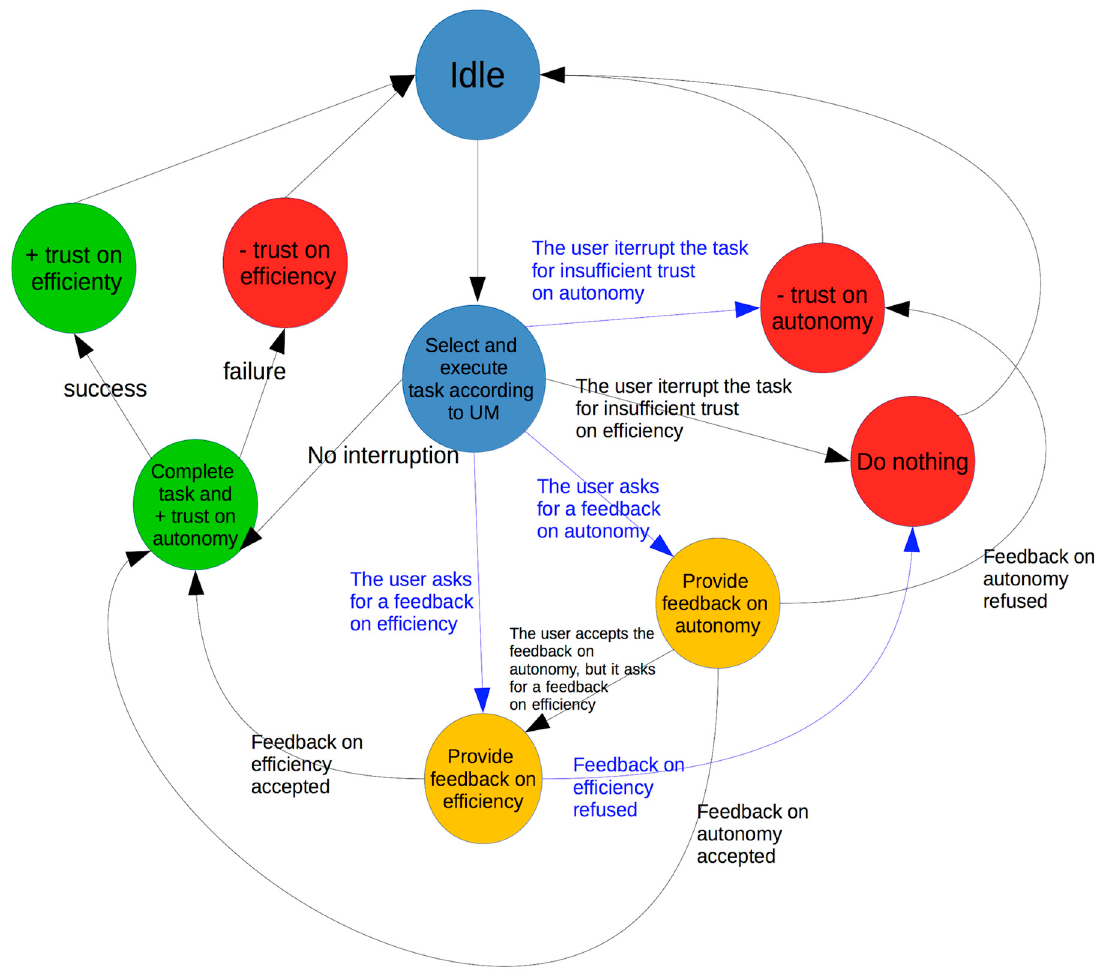
Figure 2. Graph representing the device behavior according to the estimation of the user state.